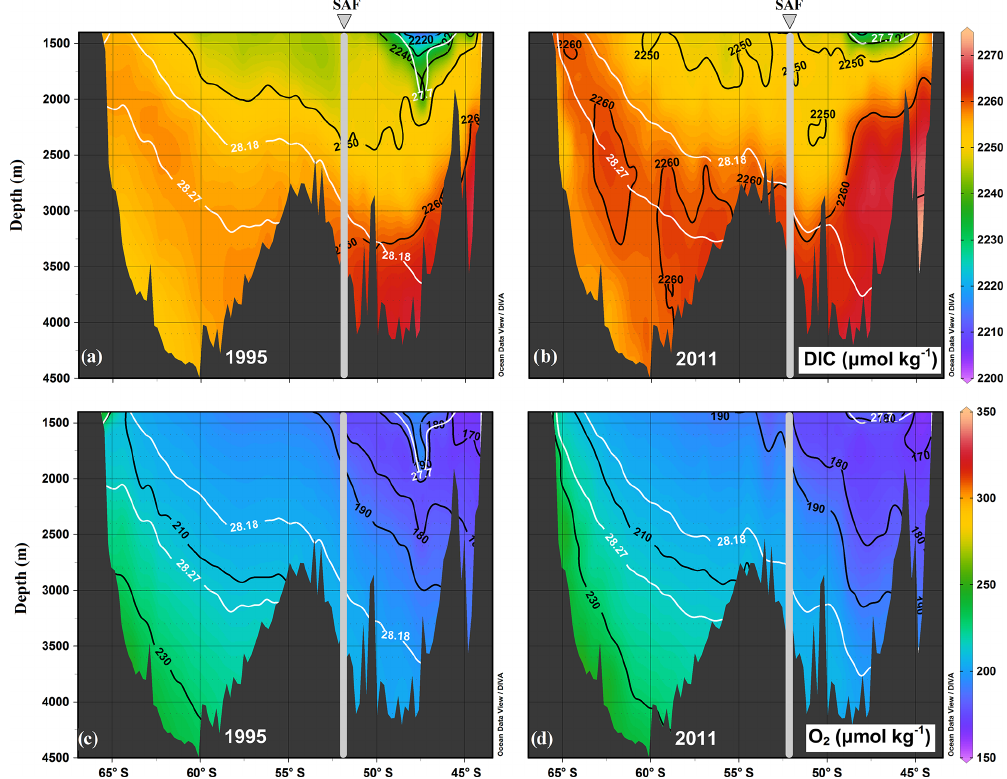
Figure 4. Distribution of (a, b) dissolved inorganic carbon (DIC) and (c, d) dissolved oxygen (O 2 ) in the 1995 and 2011 cruises for deep– bottom layers of the section. The location of the Sub-Antarctic Front (SAF) is also shown as well as the neutral surfaces ( γ n , white lines) limiting the UCDW, LCDW and AABW